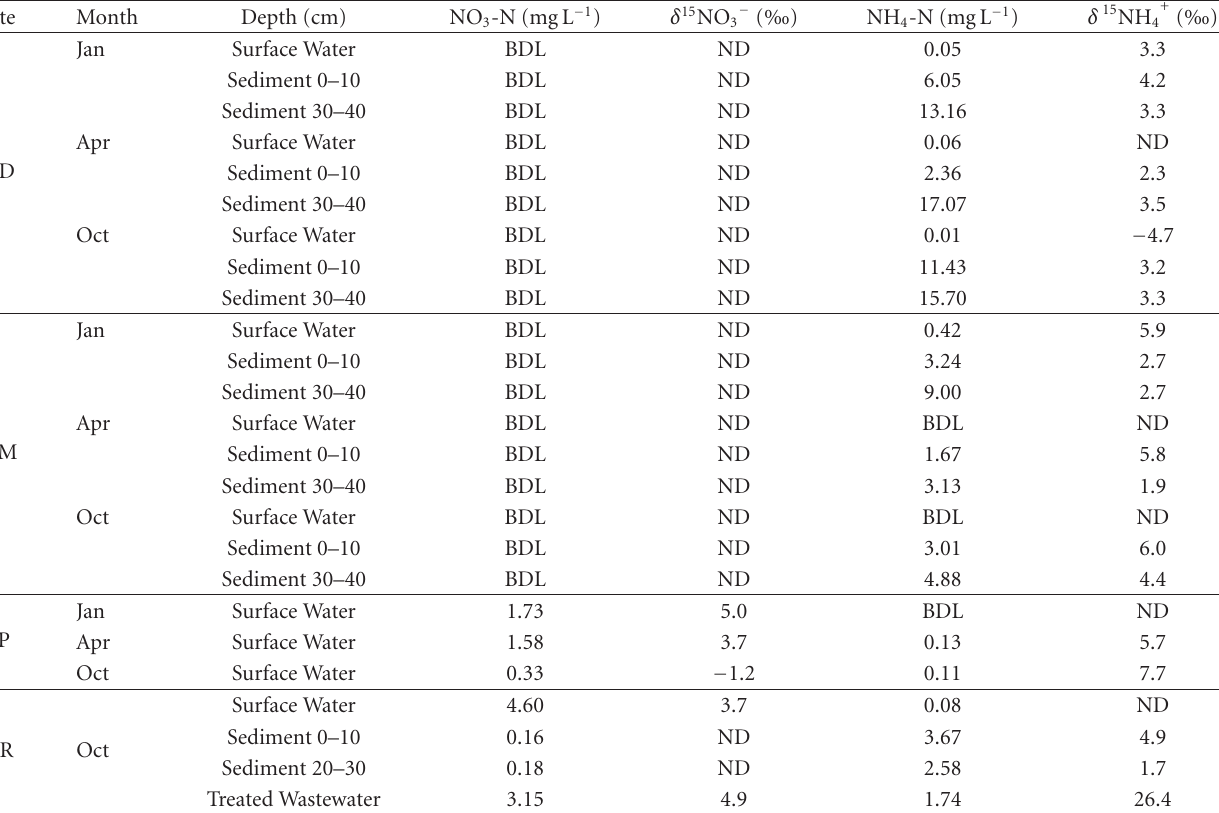
Table 1: Nitrate and ammonium data for surface and pore water in Grave’s Dock (GD), Chechessee March (CM), Chechessee Creek Club retention pond (CP), and Oyster Rake (OR).